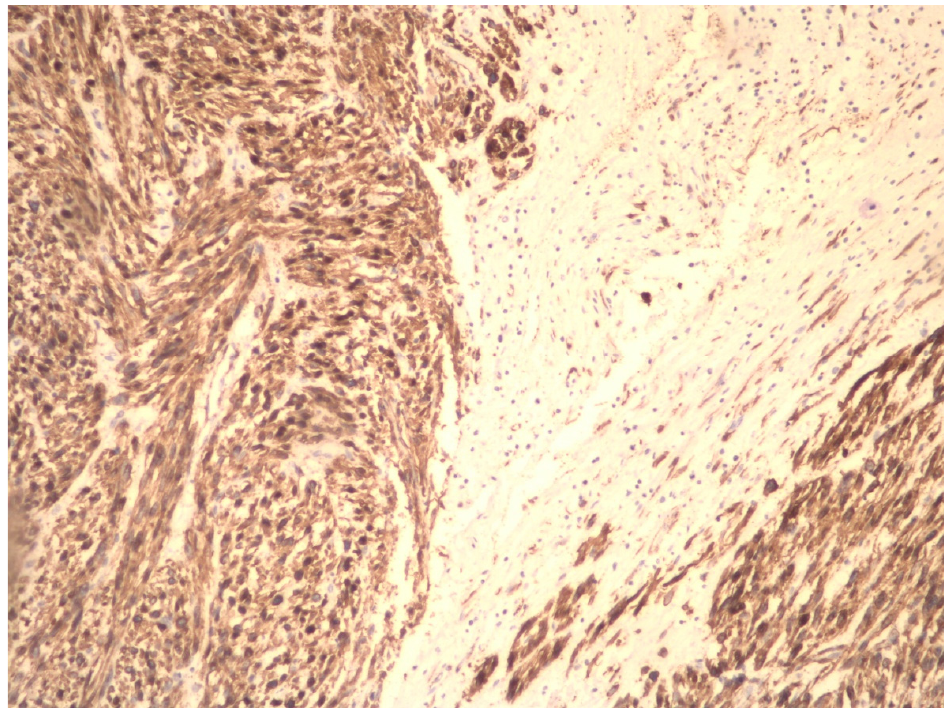
Figure 4. Immunohistochemical preparation of LMS cells (magnification at 10×). The tumor is heterogeneous with an area of necrosis. The tumor cells express smooth muscle actin. LMS prognosis is generally poor but may even worsen after vaginal and abdominal